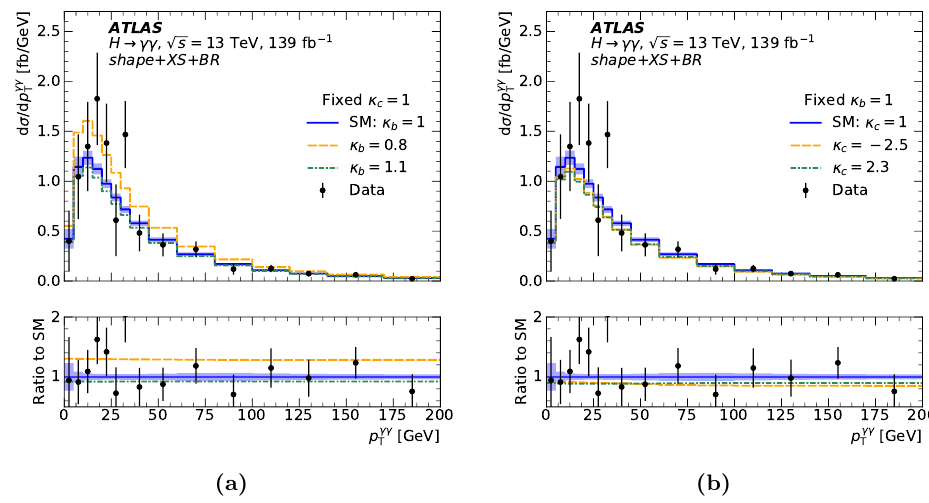
compared T and (b) κ corresponding to the upper (in green) b c